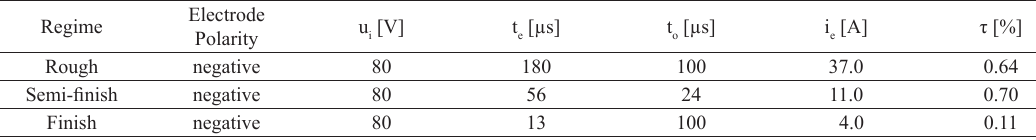
Table 1. Electrical input parameters of energy for ED-Machining experiments.